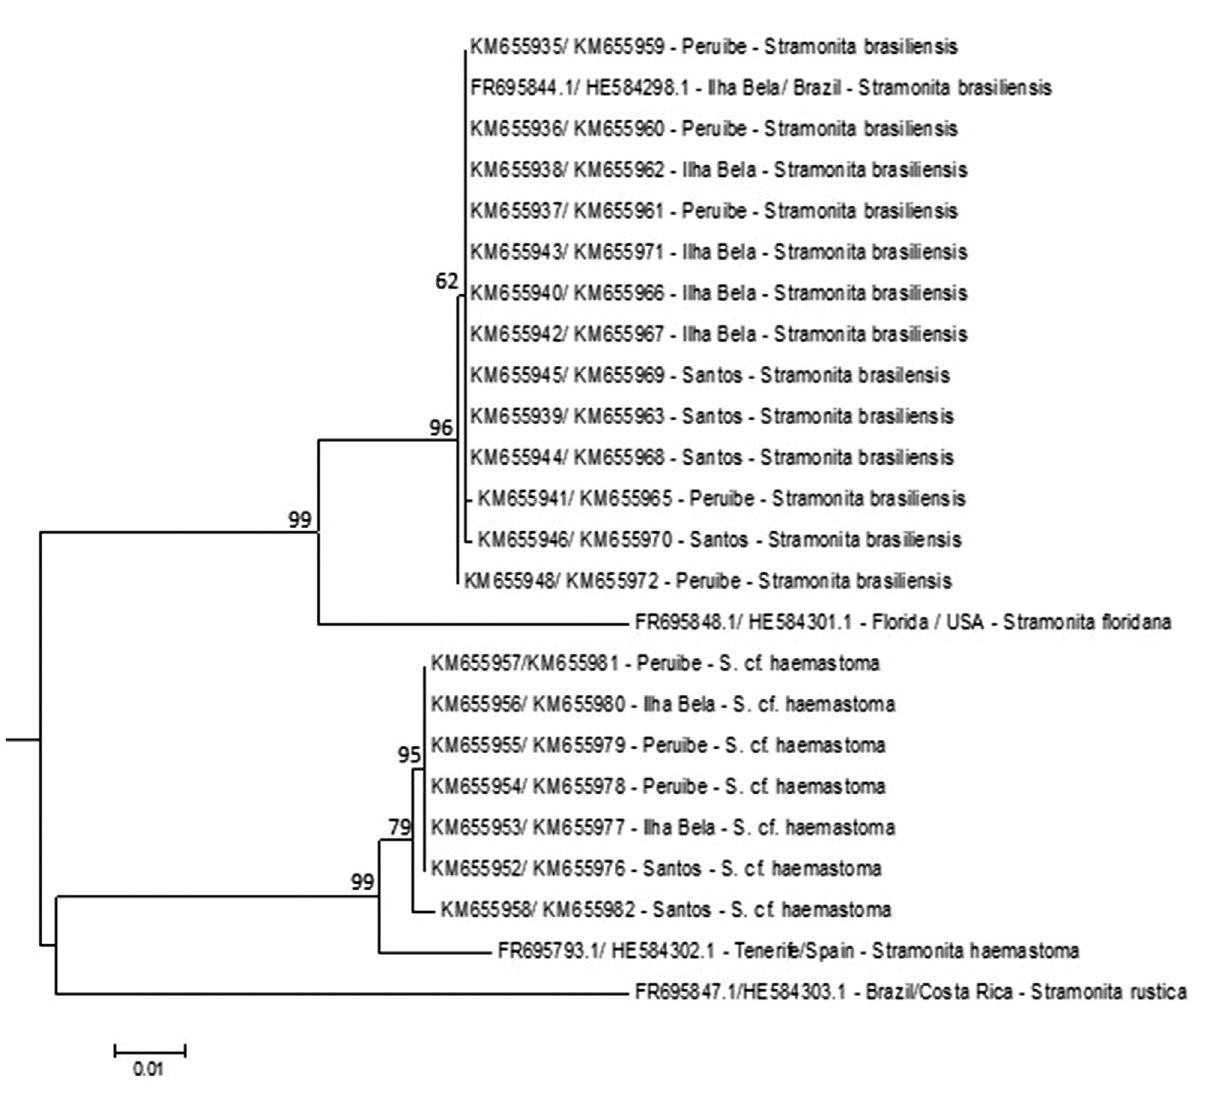
Figure 2 - Maximum Likelihood tree as a result of concatenated data sets of COI and 16S rRNA gene sequences of the Stramonita haemastoma complex. Branches are supported by bootstrap values above 50%. GenBank access numbers and location are shown in Table